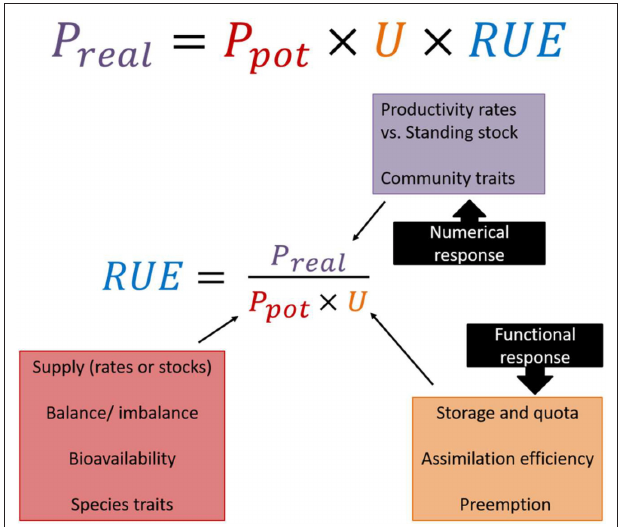
FIGURE 2 | Based on the production ecology equation, realized productivity (P real ) is a product of potential productivity (P tot ), resource uptake (U), and resource use efficiency (RUE). Rearranging the equation gives the common definition for RUE as the realized productivity divided by the amount of assimilated resources, which is influenced by resource availability and uptake. Thus, several ecological mechanisms have to be taken into account when quantifying and interpreting RUE patterns.